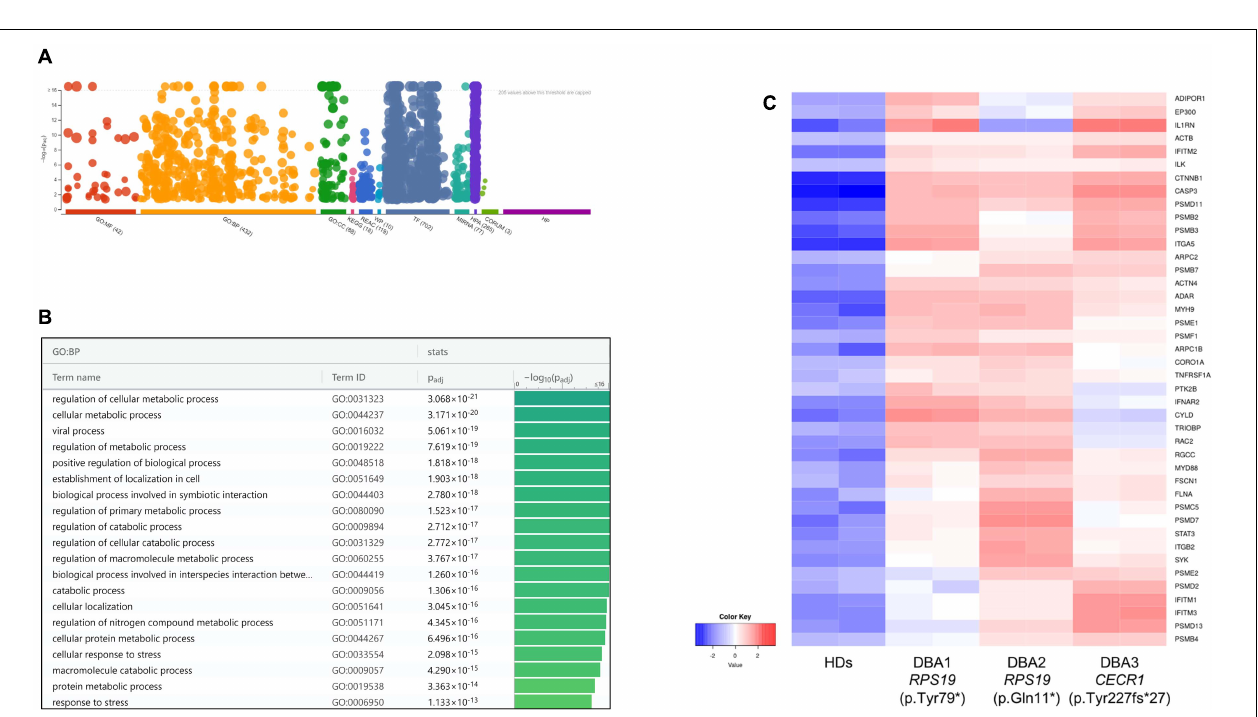
FIGURE 2 | Differentially expressed gene (DEG) numbers between DBA and healthy donors. For DEG analysis, all three DBA samples were grouped and compared with healthy donors.